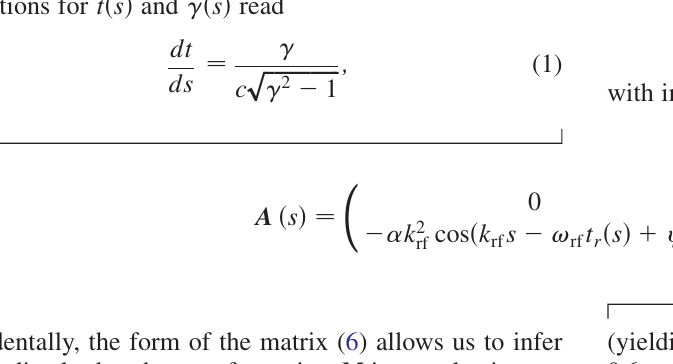
¼ best represented in terms of the variable (cid:6) , defined as (cid:6) r r s (cid:1) ct (Fig. 2, right). This quantity expresses the relative r longitudinal distance between the reference electron and an imaginary particle traveling at the speed of light. The initial conditions were specified so that as the reference ¼ 0 , particle enters the structure ( s ¼ 0 : 6 m ) we have (cid:6) r i.e., the rf phase is c ¼ c 0